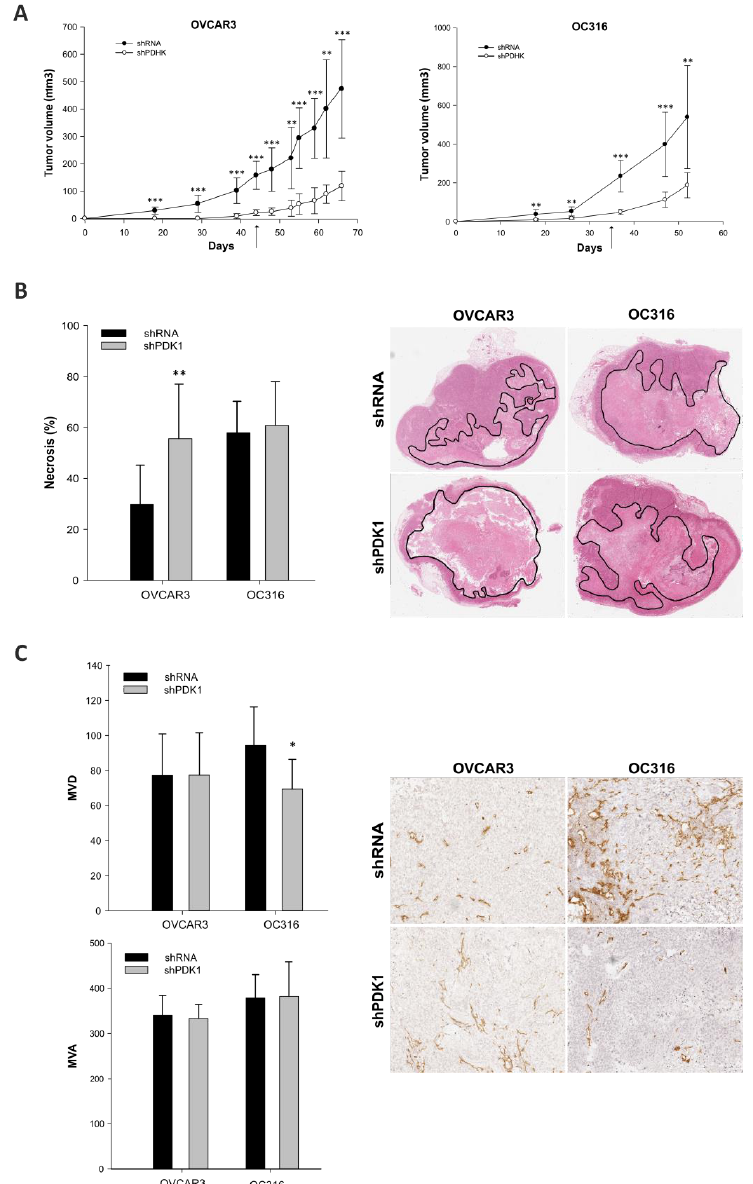
Figure 4. Effects of PDK1 silencing on tumor growth and angiogenesis. ( A ) Kinetics of tumor development in NOD/SCID mice s.c. injected with silenced cells (shPDK1) and control cells (shRNA) in OVCAR3, and OC316, (n = 4 mice for group), ** p < 0.01 *** p < 0.001, Mann–Whitney test. Arrows indicate the time of sacrifice in control tumors harvested when their volumes were comparable to shPDK1 tumors—i.e., 100 and 200 mm 3 in the case of OVCAR3 and OC316 tumors, respectively. ( B ) Histologic images and columns indicate quantitative analysis of necrotic areas in n = 8 different tumors for each group, ** p < 0.01, Mann–Whitney test. Original magnification 1.25×. ( C ) Microvessel density (MVD) and microvessel area (MVA) evaluations were quantified by image analysis software on digitalized slides. * p < 0.05. Columns show mean ± SD values (n = 8 fields for tumor; n = 4 tumors for group), *** p < 0.001, Mann–Whitney test. Original magnification 10 ×